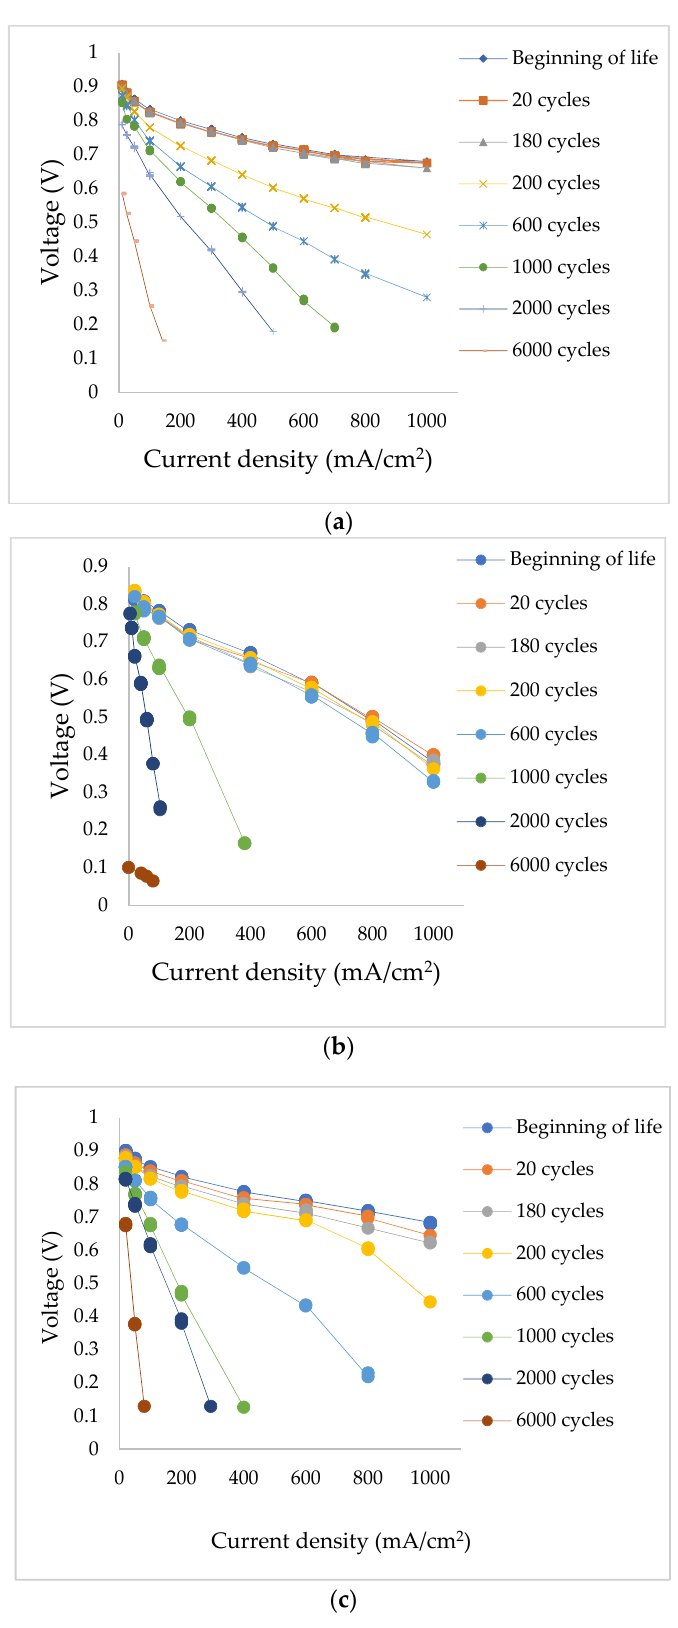
Figure 7. Performance curves taken during potential cycling for ( a ) MEA #1M, ( b ) MEA #2M, ( c ) and the stratified CCL MEA #6.